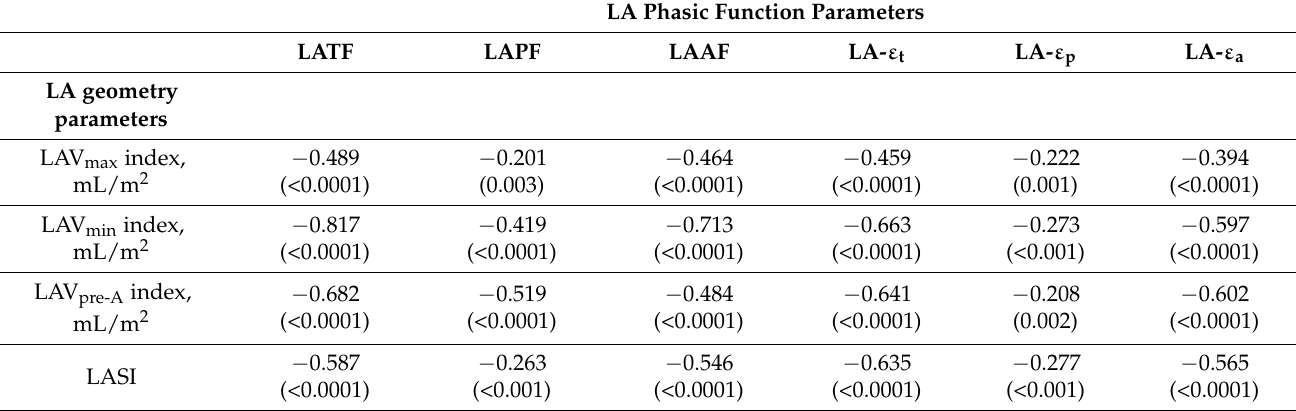
Table 4. Correlations between LA function and parameters of LA geometry and LV function in the NIDCM